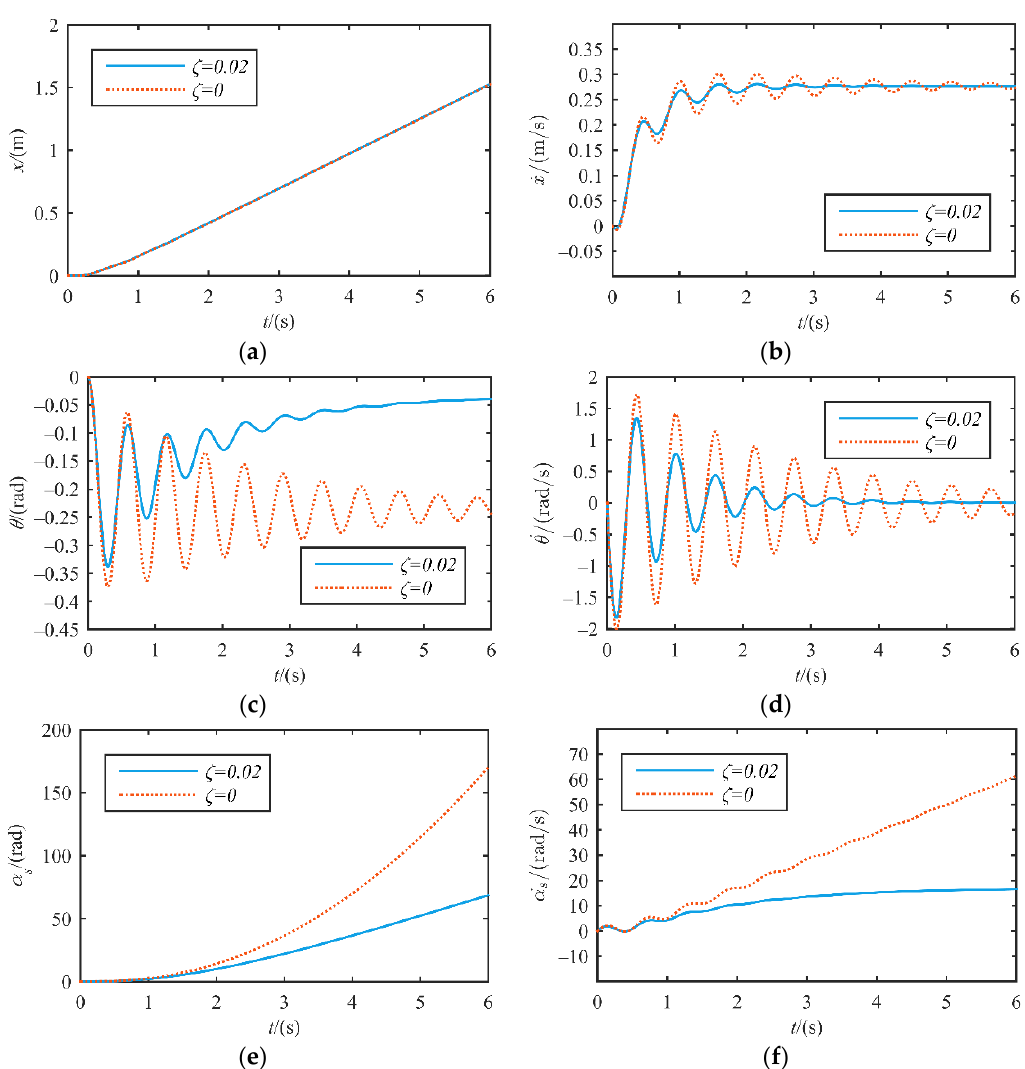
Figure 7. Time-varying states of the generalized coordinates. ( a ) Travel distance of the robot; ( b ) Speed of the robot; ( c ) Angle of the IDU platform; ( d ) Angular velocity of the IDU platform; ( e ) Angle of the spherical shell; ( f ) Angular velocity of the spherical shell.